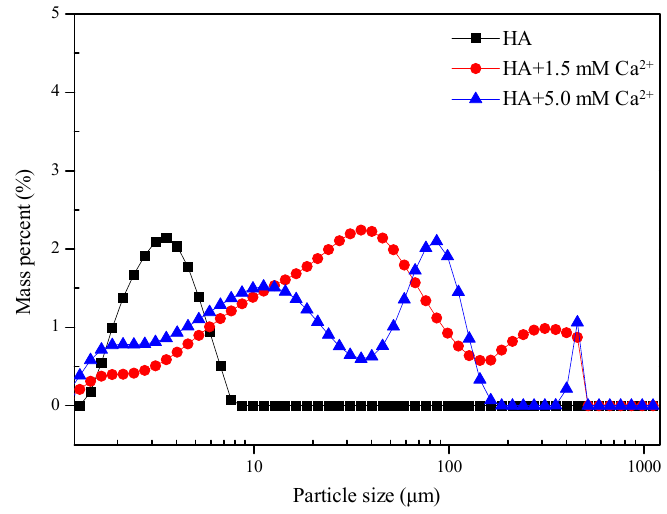
Figure 4. PSD of HA solution with different Ca 2+ concentrations.